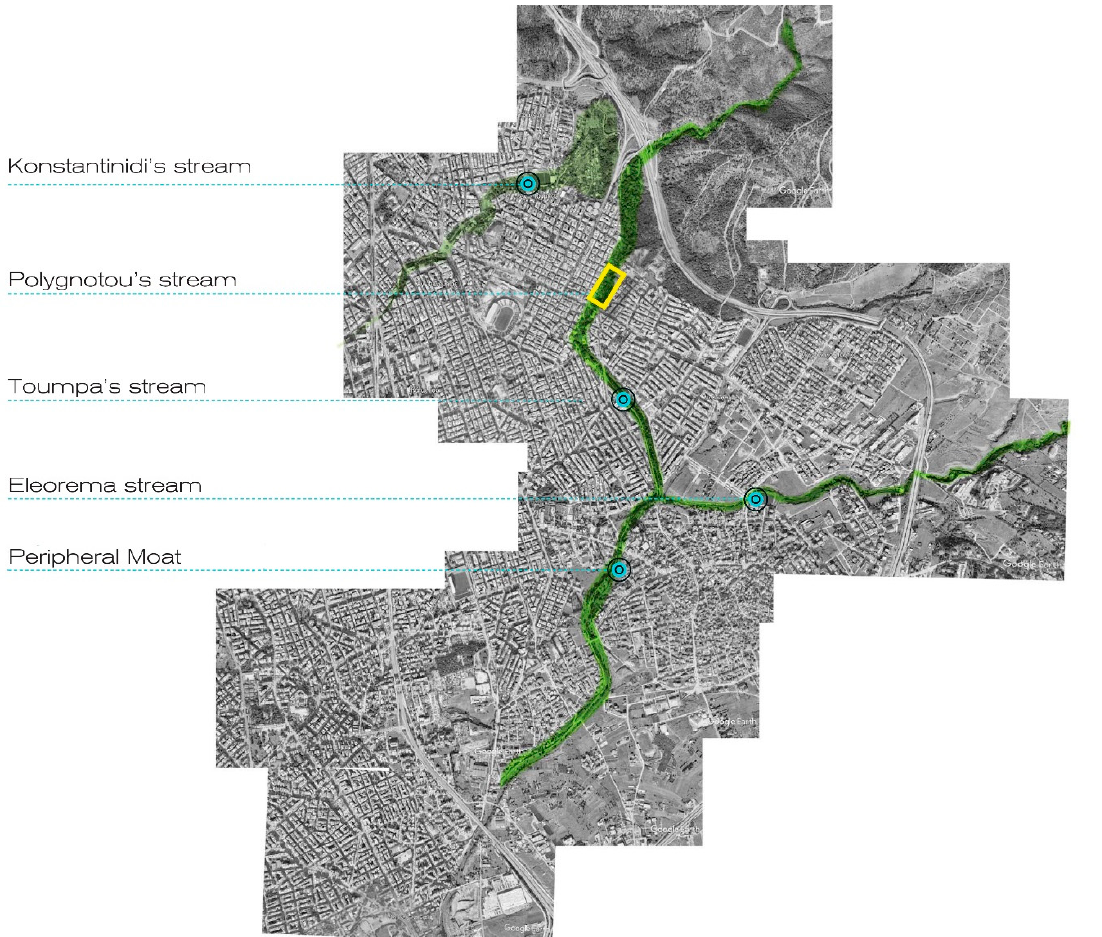
Figure 2. Streams and the peripheral moat at eastern Thessaloniki. Source: [21].